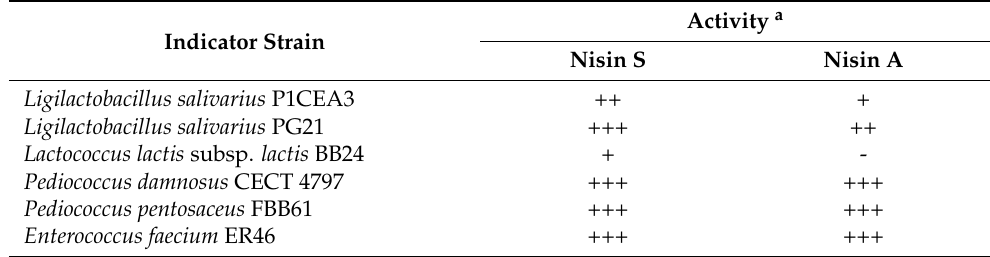
Table 3. Antimicrobial activity and spectrum of activity of the purified nisin S and nisin A, against different indicator strains.